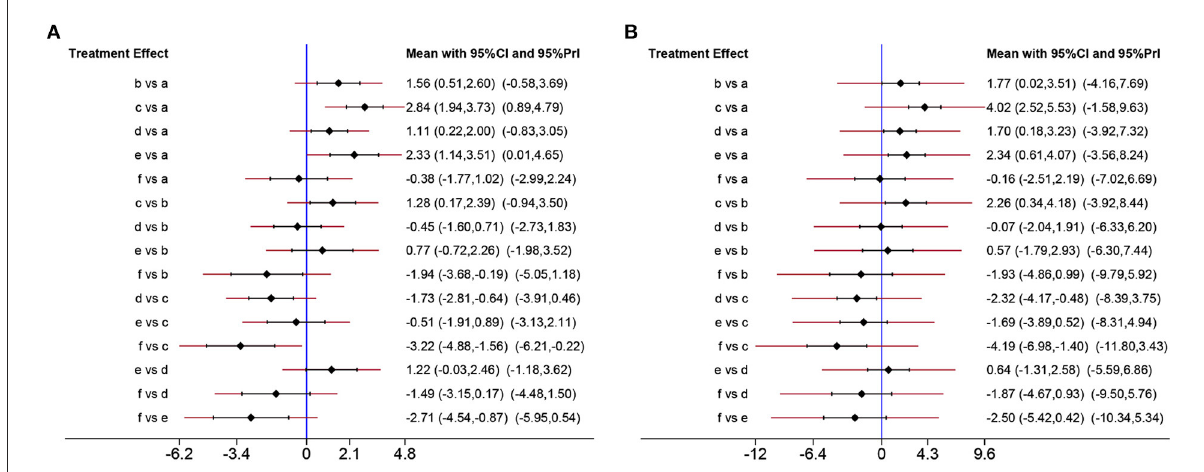
FIGURE6 Network analysis of the effects of metformin at different doses. (A) Forest plot of effect size in different metformin doses according to data on 28th day. (B) Forest plot of effect size in different metformin doses according to data on 21th day. a, Control; b, 10 mg/kg metformin; c, 50 mg/kg metformin; d, 100 mg/kg metformin; e, 200 mg/kg metformin; f, 320 mg/kg